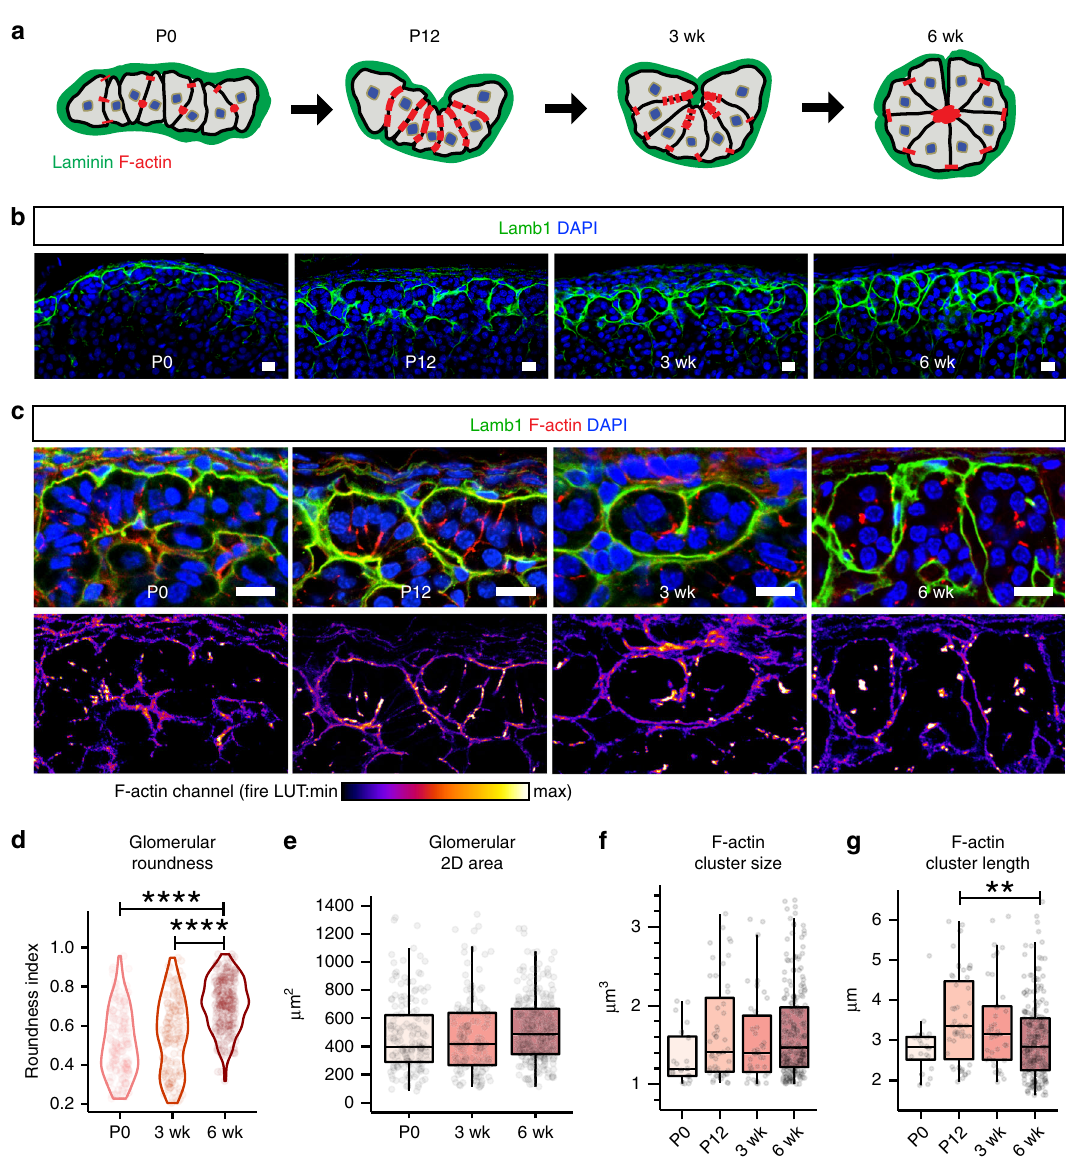
Fig. 3 Rosette formation underlies postnatal glomerular morphogenesis. a Schematic of glomerular morphogenesis. b , c Time course of postnatal glomeruli morphogenesis. b Lamb1 (green) marks the basement membrane surrounding the developing glomeruli. c F-actin (red) distribution within the developing glomeruli (outlined by Lamb1 in green) at indicated postnatal stages. DAPI (blue) marks nuclei. Bars, 10 μ m. Lower panels show F-actin channel alone in fi re LUT. d Measurement of glomerular roundness at indicated stages. Kruskal – Wallis test, P < 0.0001; P0 versus 6 week, Dunn ’ s test, **** P < 0.0001; 3 week versus 6 week, Dunn ’ s test, **** P < 0.0001. e Measurement of glomerular cross-sectional area at indicated stages. For d and e , at least three animals from each time point and at least fi fty glomeruli per animal were examined. f Measurement of F-actin cluster size at indicated stages. g Measurement of F-actin cluster length at indicated stages. Kruskal – Wallis test, P < 0.01; P12 versus 6 week, Dunn ’ s test, ** P < 0.01. For f and g , at least two animals from each time point and at least ten F-actin punctae per animal were examined. For all measurements, fi rst a Kruskal – Wallis rank sum test was performed, and if signi fi cant ( P < 0.05), followed by Dunn ’ s multiple comparison test for each pair. In all boxplots, box boundaries represent the 25th and 75th percentiles, whiskers represent the 5th and 95th percentiles, center lines represent median. Source data are provided as a Source Data fi